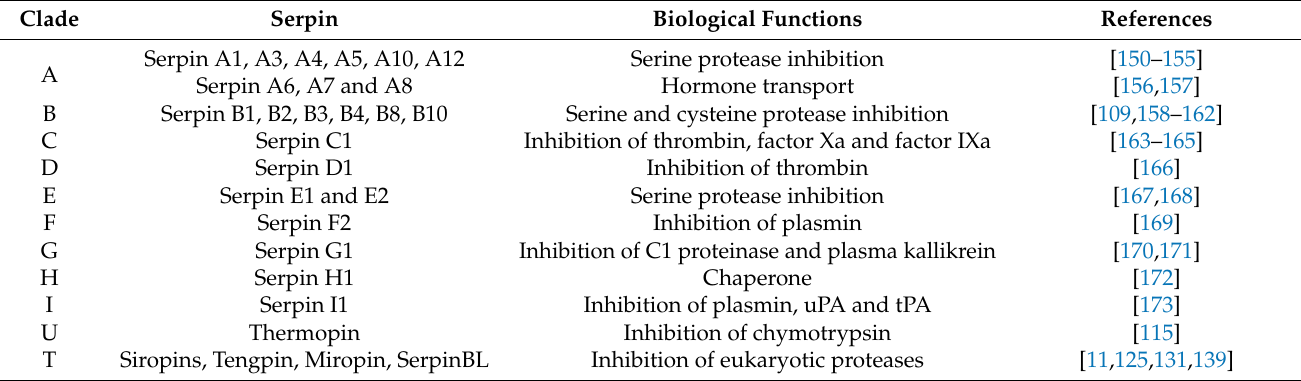
Table 1. Serpin groups and their main